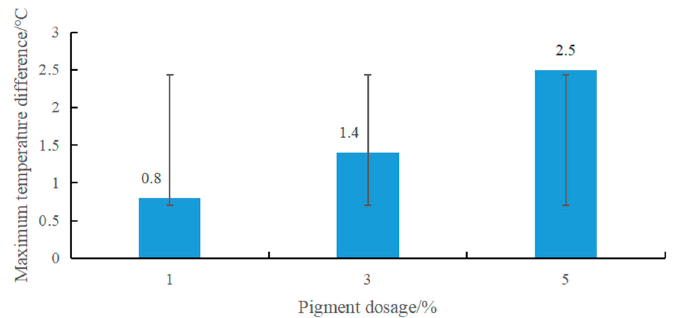
Figure 7. Temperature difference value of different pigment content.